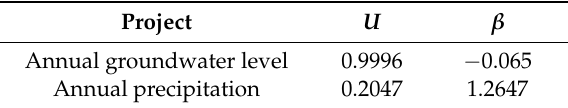
Table 1. M-K trend test results